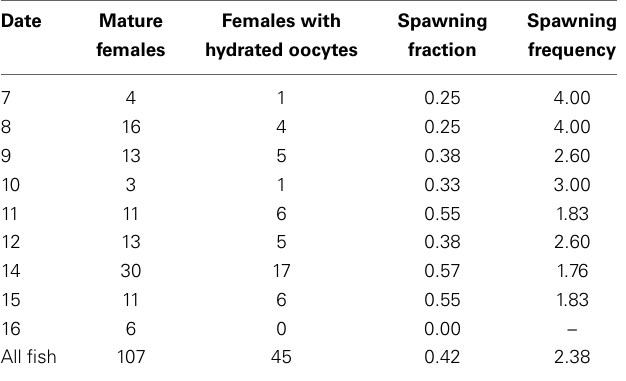
Table 4 | Daily spawning fraction and spawning frequency for fish collected from 7 through 16 May 2012.